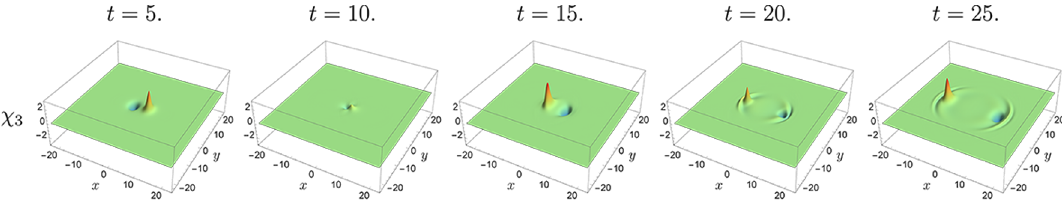
Figure 26 . Snapshots of χ 3 for the head-on collision of type II anti-parallel non-Abelian vortices with initial velocity u = 0 . 7 . The vortices bounce-back due to the repulsive force dominating in the type II case, however the orientations are exchanged at the moment of collision.